Question: Write the caption for this figure.
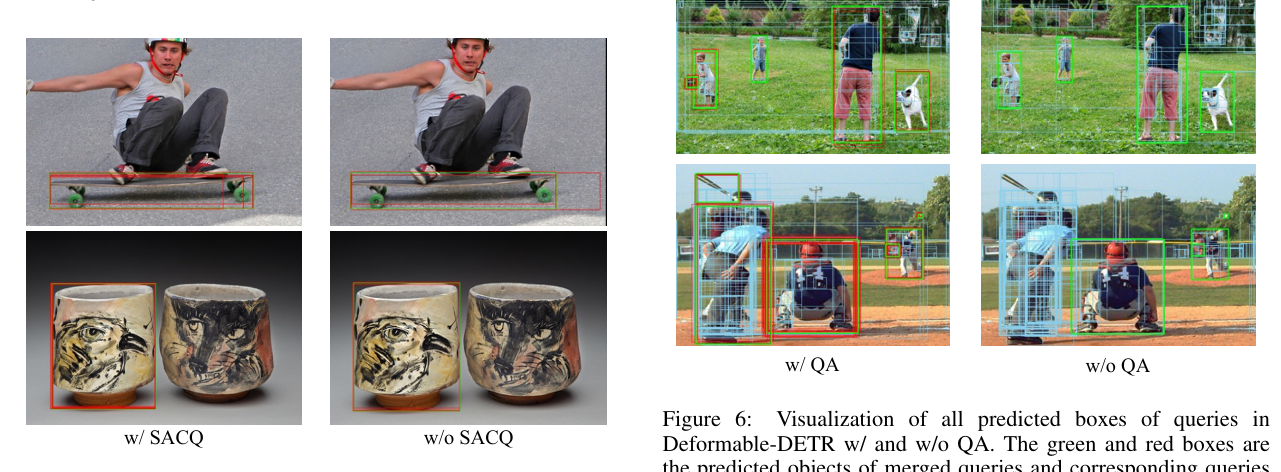
Answer: Visualization of activated query’s bounding box (green boxes) and its highly overlapped (IoU > 0.8) bounding boxes (red boxes) from queries with suppressed low scores. Improved content query initialization from SACQ generates more potential queries with similar bboxes, which can be further addressed by QA.